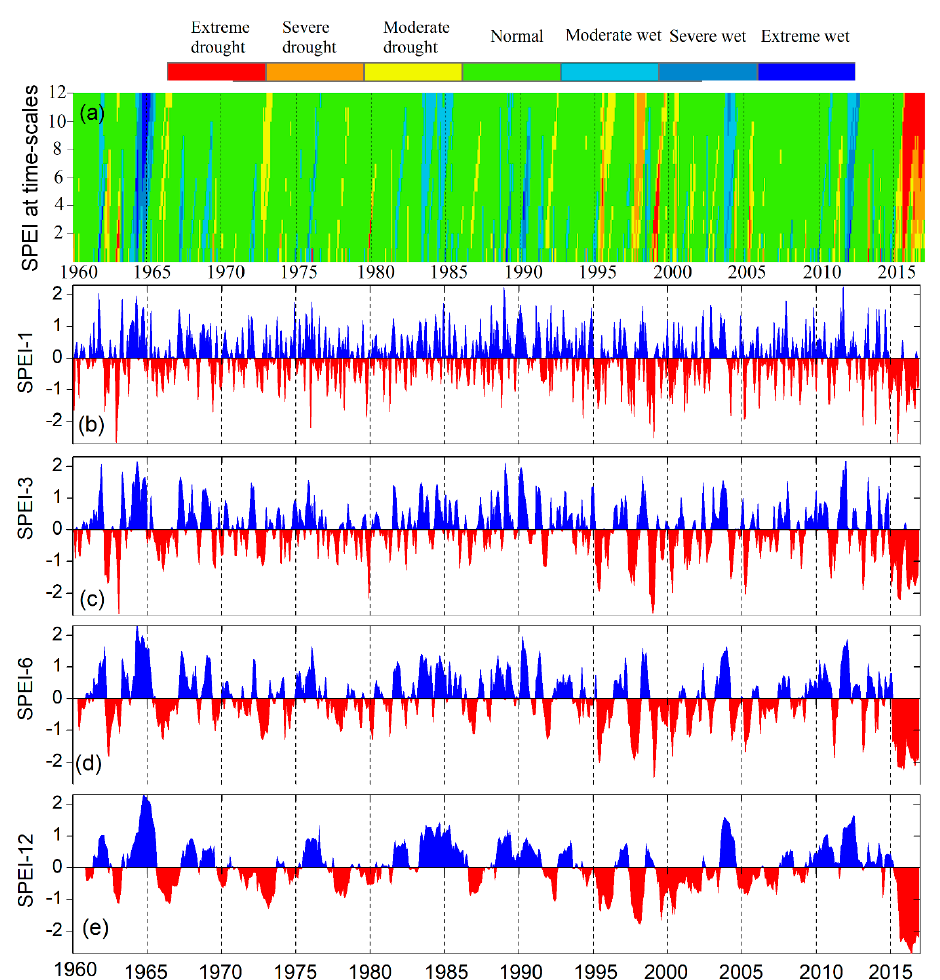
Figure 3. ( a ) Spatiotemporal evolution of SPEI series with 1- to 12-month lags from 1960 to 2016 and ( b–e ) temporal evolution of SPEI at 1-, 3-, 6-, and 12-month lags across the Shanxi Province.